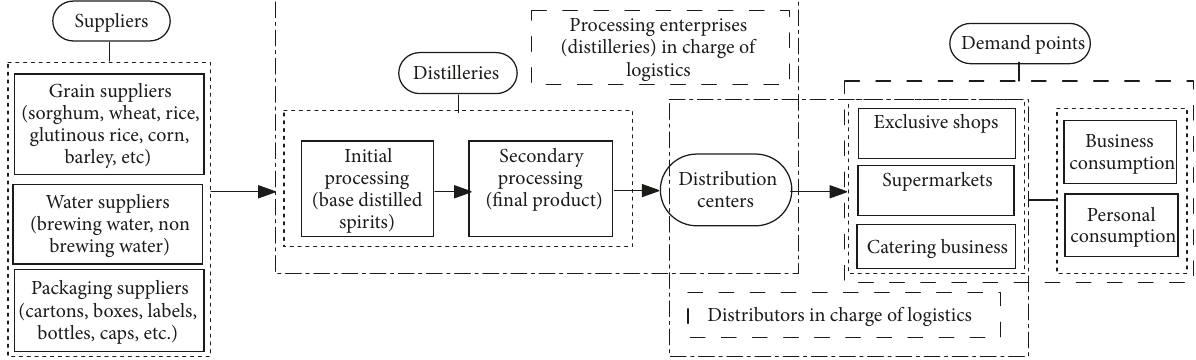
Figure 4: Baijiu supply